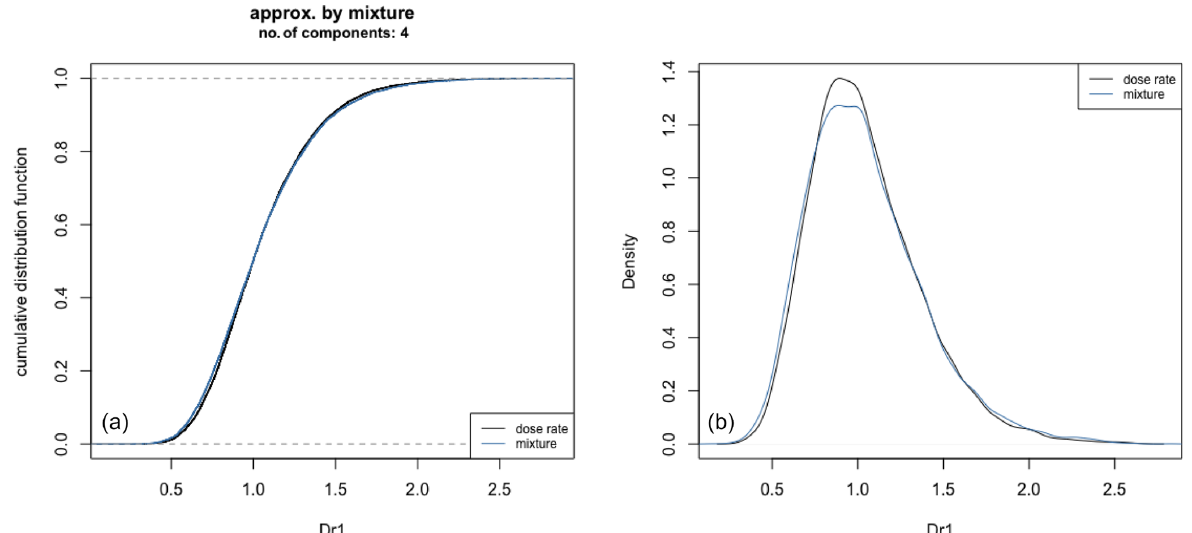
Figure 3. Approximation of the D r distribution with a mixture of normal (Gaussian) functions.